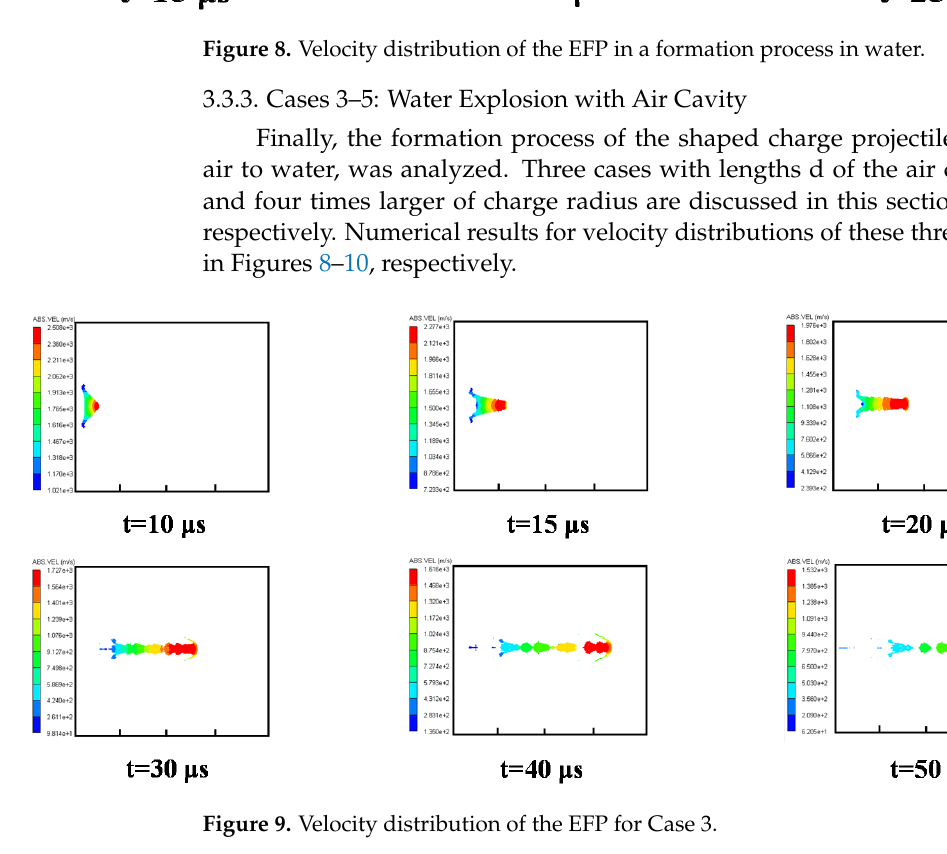
Figure 8. Velocity distribution of the EFP in a formation process in water.